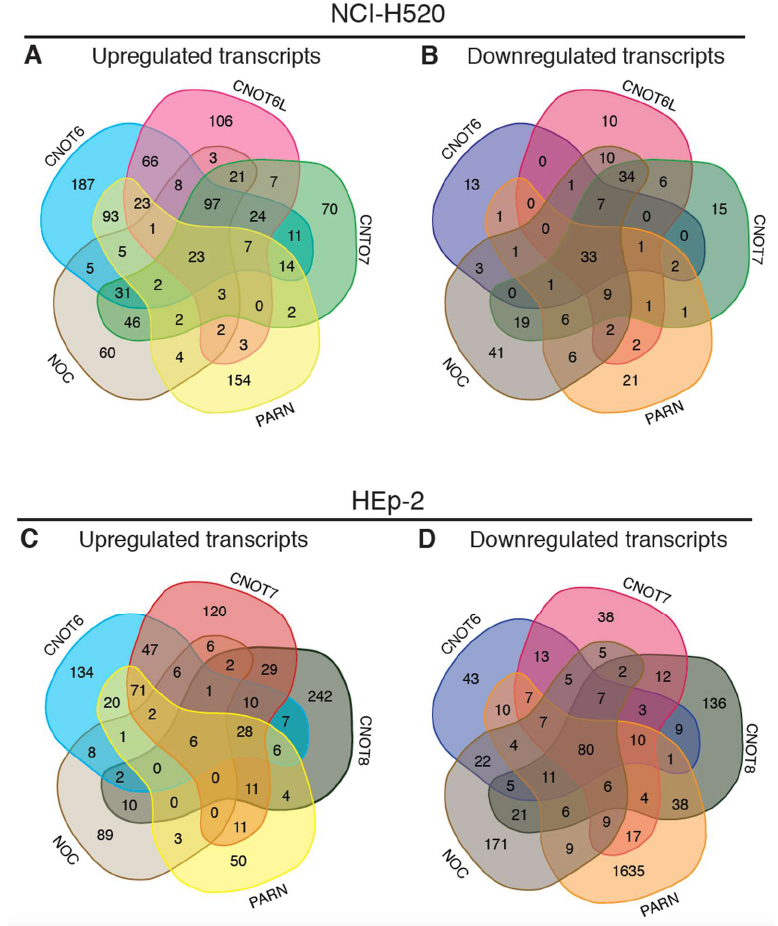
Figure 2. Transcripts affected by each deadenylase in NCI-H520 and HEp-2 cells. ( A ) Venn diagrams showing upregulated transcripts of CNOT6, CNOT6L, CNOT7, PARN, and NOC KD in NCI-H520 cells. ( B ) Venn diagrams showing downregulated transcripts of CNOT6, CNOT6L, CNOT7, PARN, and NOC KD in in NCI-H520 cells. ( C ) Venn diagrams showing upregulated transcripts of CNOT6, CNOT7, CNOT8, PARN, and NOC KD in HEp-2 cells. ( D ) Venn diagrams showing downregulated transcripts of CNOT6, CNOT7, CNOT8, PARN, and NOC KD in HEp-2 cells. The numbers represent differentially expressed transcripts, the levels of which are altered by FC 2.0 upon silencing of the indicated deadenylase. 2.3. Deadenylase Silencing–Comparison with MCF7 Cell Line To extend the previous analysis, we included data from silencing of CNOT6, CNOT6L, CNOT7, and CNOT8 from another cell line, namely, MCF7 (derived from pleural effusion of breast carcinoma), based on previous studies [52,53]. In the studies of Aslam and coworkers, and Mittal and coworkers, the analysis is based on 1.5-fold changes (FC 1.5) of the levels of transcripts. To acquire comparable results, we modified our analysis on NCI-H520 and HEp-2 cells, calculating alterations in the transcript levels by FC 1.5. Upon the silencing of CNOT6 in NCI-H520 and HEp-2, and compared to the silencing of CNOT6/CNOT6L in MCF-7 cells, we found 45 common upregulated genes